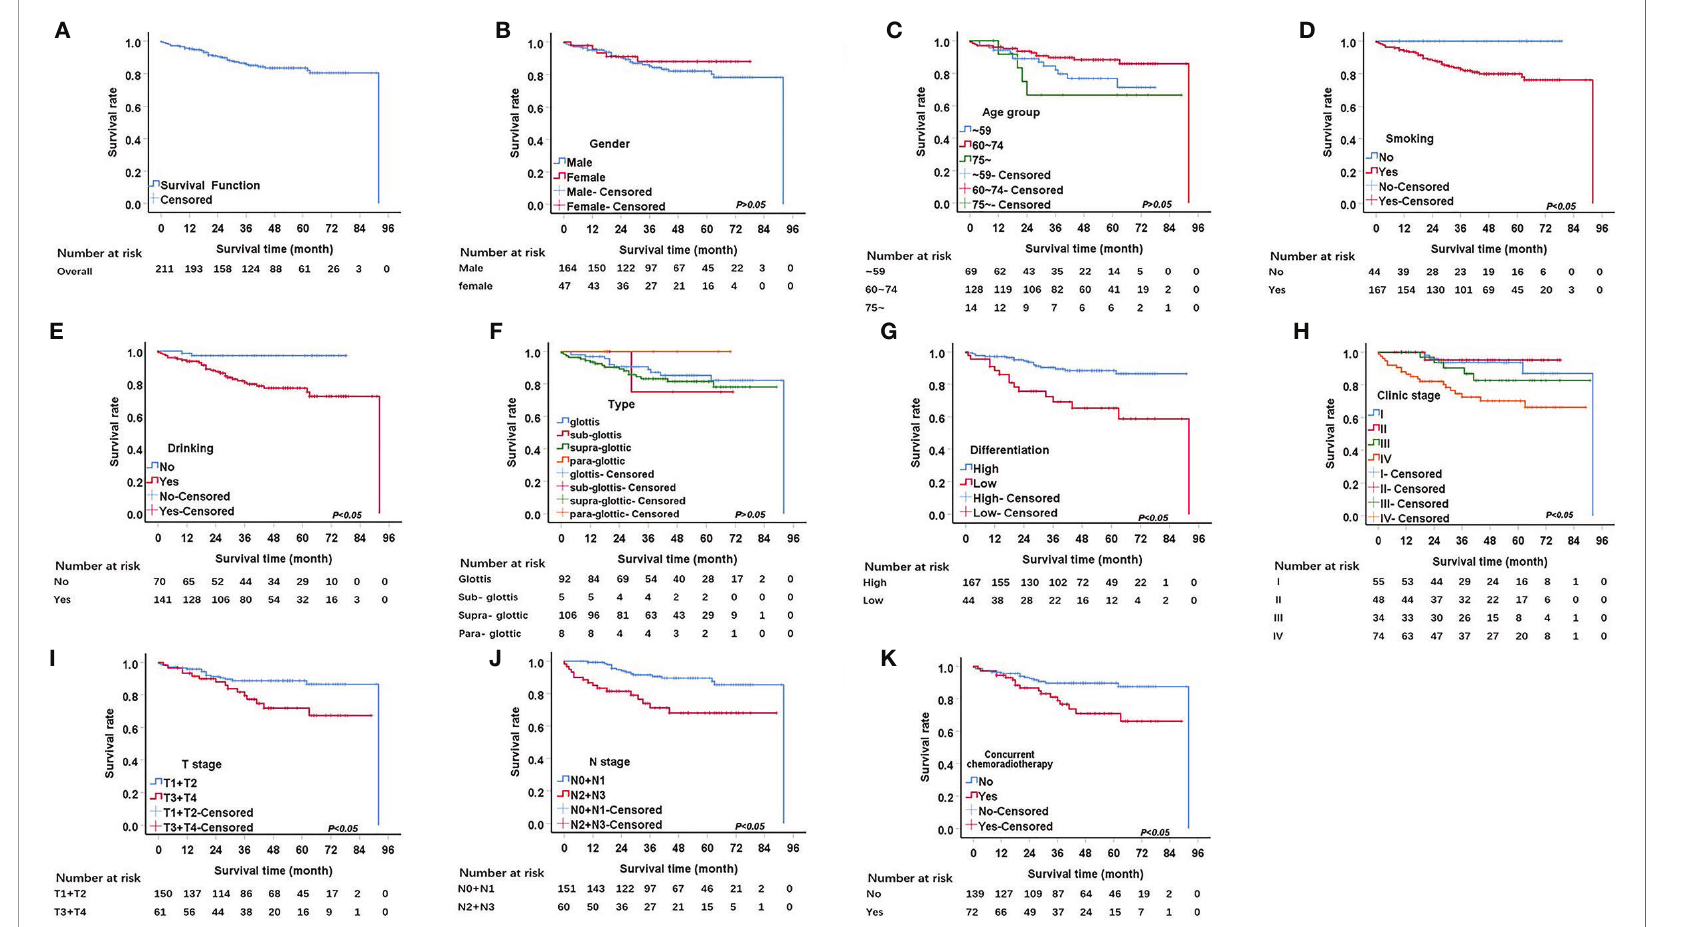
FIGURE 1 | Kaplan.-Meier curves for overall survival (OS). (A) Kaplan-Meier curves for overall survival rate. (B) There was no signi fi cant differences between male and female, p>0.05. (C) There was no signi fi cant differences among age group, p>0.05. (D) The survival rate for tabacoo users was signi fi cantly lower than non-smokers, p=0.005. (E) The survival rate for those who used to drink was signi fi cantly lower than those did not, p=0.001. (F) There was no signi fi cant difference among group of type, p>0.05. (G) The survival rate for those with low pathological differentiation tumors was signi fi cantly lower than those were high, p=0.000. (H) The survival rate for patients with clinical stage IV was signi fi cantly lower than those with I, II, III, respectively, p=0.001. (I) The survival rate for those at stage T3 and T4 was signi fi cantly lower than those at T1 and T2, p=0.017. (J) The survival rate for those at stage N2 and N3 was signi fi cantly lower than those at N1 and N0, p<0.05. (K) The survival rate for those with concurrent chemoradiotherapy was signi fi cantly lower than those not,